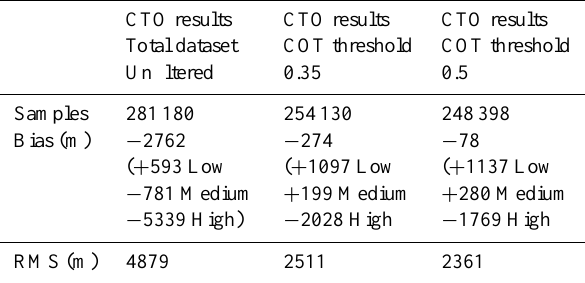
Table 5. Cloud top height (CTO) results from CLARA-A1/PPS evaluated using unfiltered and filtered CALIOP results. Mean er- rors (Bias) and RMS errors are given for unfiltered (column 1) con- ditions and for two filtered conditions (columns 2 and 3) with two different cloud optical thickness thresholds. Mean errors are also given for the three cloud layer groups of low-level, medium-level and high-level clouds (explained in